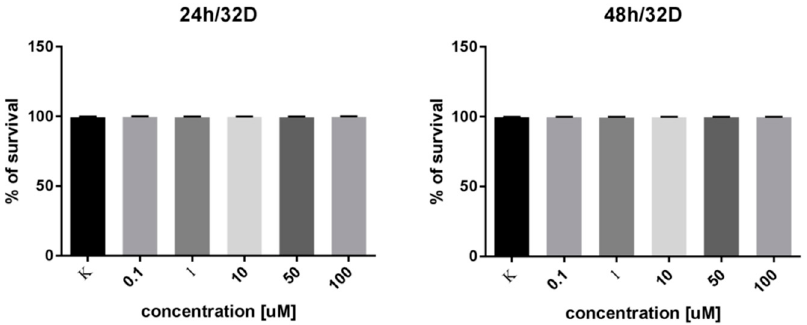
Figure 9. Survivability of myeloblast-like cell line derived from bone marrow at different concentrations of 4 . No significant differences in cell survival using a t -test were shown.